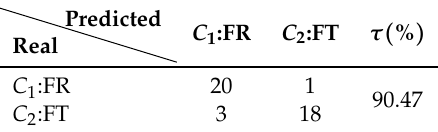
Table 3. The confusion matrix corresponding to the proposed Kohonen three class classification method. τ ( % ) corresponds to the classification accuracy. Real Predicted